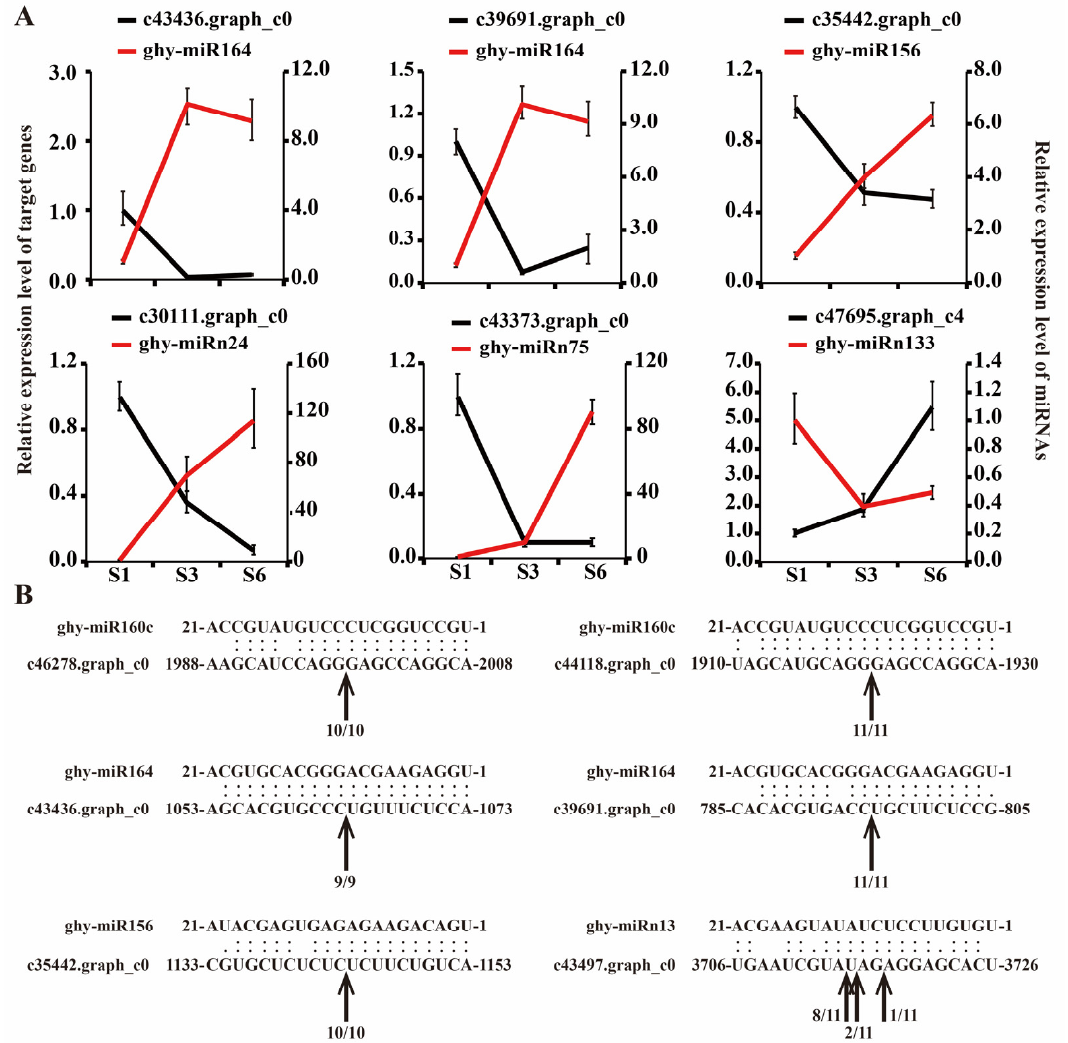
Figure 8. Validation of miRNA predicted targets. ( A ) Expression of eight candidate miRNA ‐ mRNA pairs using qRT ‐ PCR. Relative expression levels of miRNAs and candidate target genes were nor ‐ malized to the reference genes snRNA U6 and GhACTIN (GenBank accession number AJ763915), respectively. The expression level of S1 was defined as “1”. ( B ) Cleavage sites identified by 5 ′‐ RLM ‐ RACE assay in ray petals. Positions of the cleavage sites are indicated by arrows with the proportion of sequenced clones.